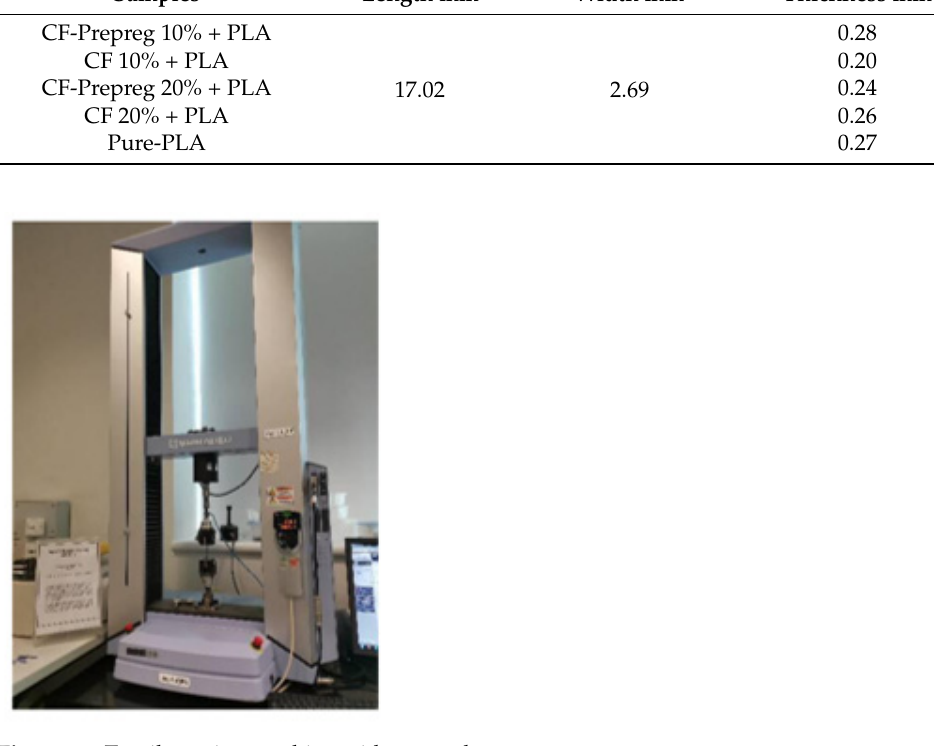
Figure 11. Tensile testing machine with a sample. Table 1. Dimensions of the prepared tensile test